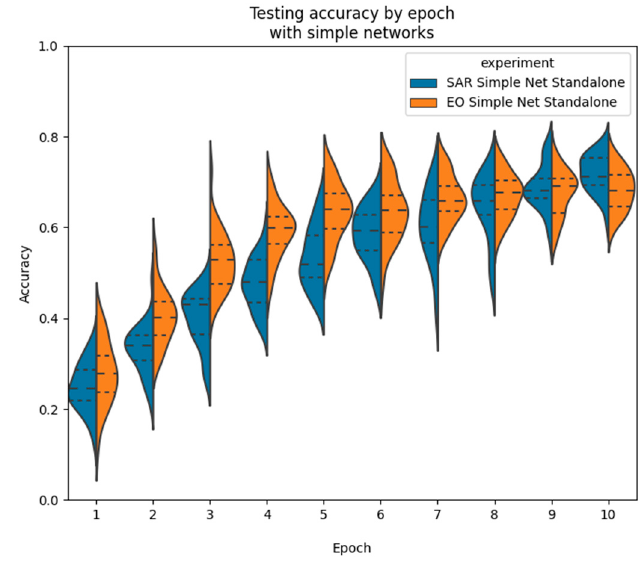
Figure 13. Simple net SAR vs. EO distributions during training by epoch.